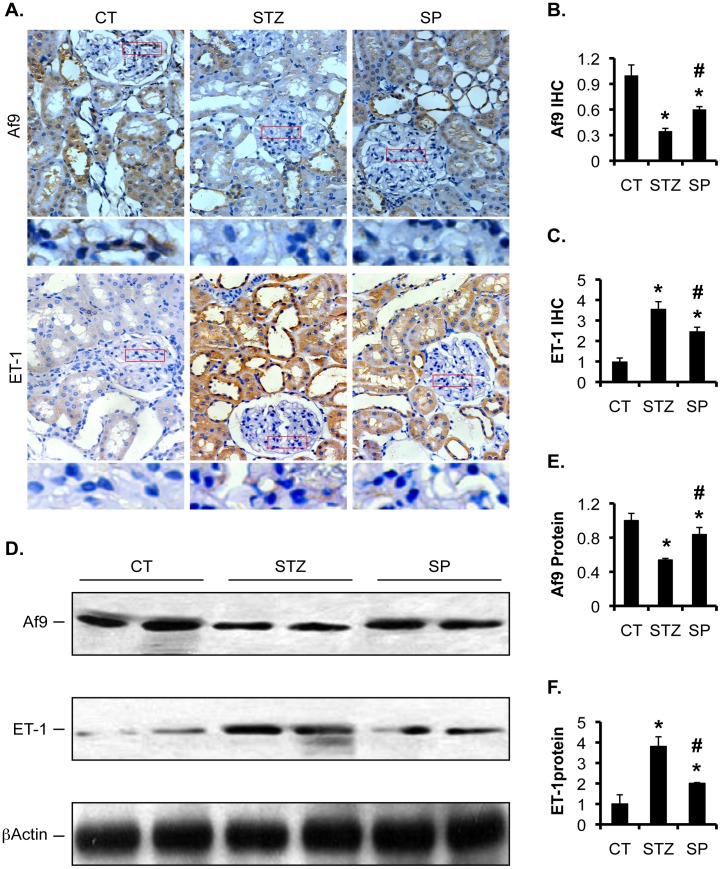
Spironolactone partially normalized protein expression of Af9 and ET-1 in STZ-induced diabetic rats.(A) As in Fig. 1, representative IHC images showing expression of Af9 and ET-1 in kidneys of rats as indicated. Boxed areas in the glomeruli were amplified and shown at the bottom of each panel (B–C) IHC intensity in A was quantified using ImageJ64, averaged within each group, and plotted as indicated, with the relative intensities in controls (CT) set to 1. (D) Representative IBs showing expression of Af9, ET-1, and β-actin as loading control in the cortex of rat kidneys as indicated. (E–F) The intensity of each band in D was quantified using ImageJ64, normalized to that of β-actin, and plotted as indicated, with the relative intensities in controls (CT) set to 1. In all cases, n = 8 rats/group. *P<0.05 vs. CT. #P<0.05 vs. DN.